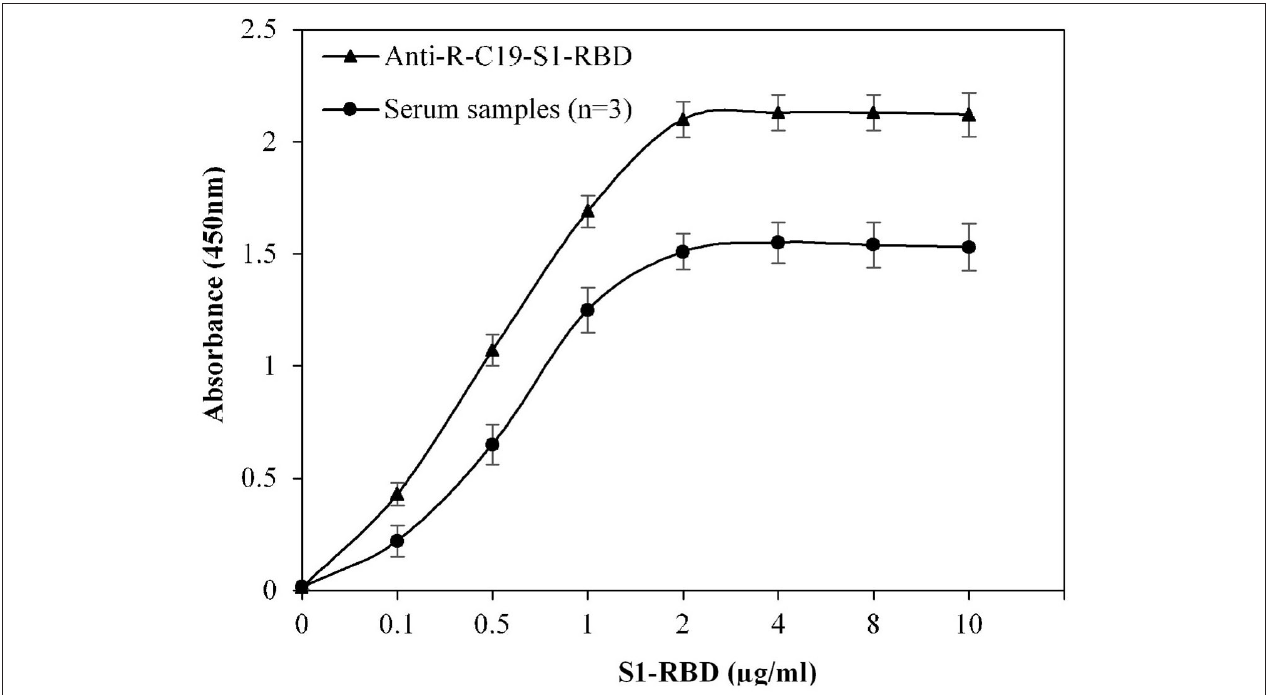
FIGURE 1 | Optimization of antigen (S1-RBD) concentration for ELISA. Serum samples from COVID-19 convalescent individuals ( n = 3) were used in the assay. Anti-R-C19-S1-RBD IgG was used a positive control. Each sample was run in triplicate under similar conditions.